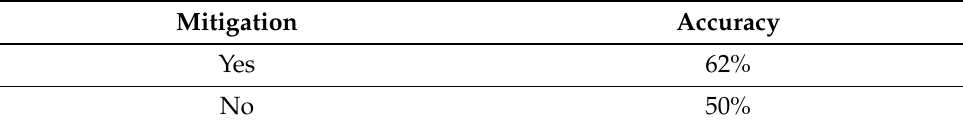
Table 1. Test set accuracy for the cases with/without